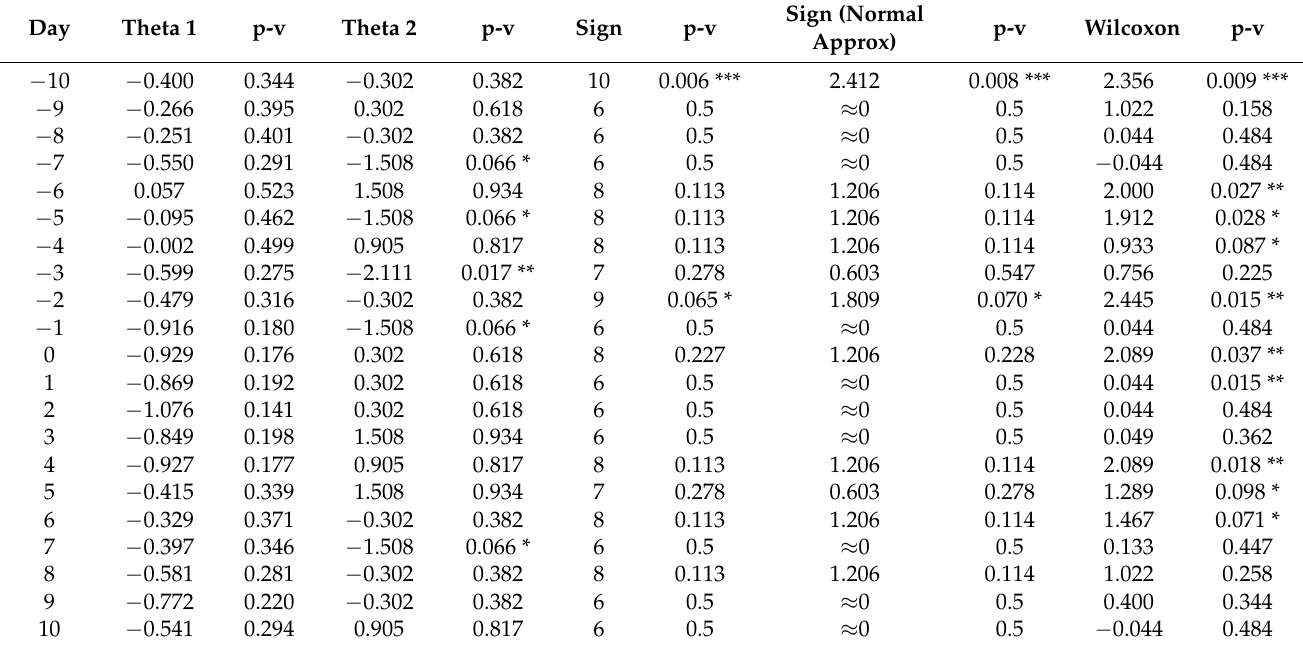
Table 3. Event study test, event 1.